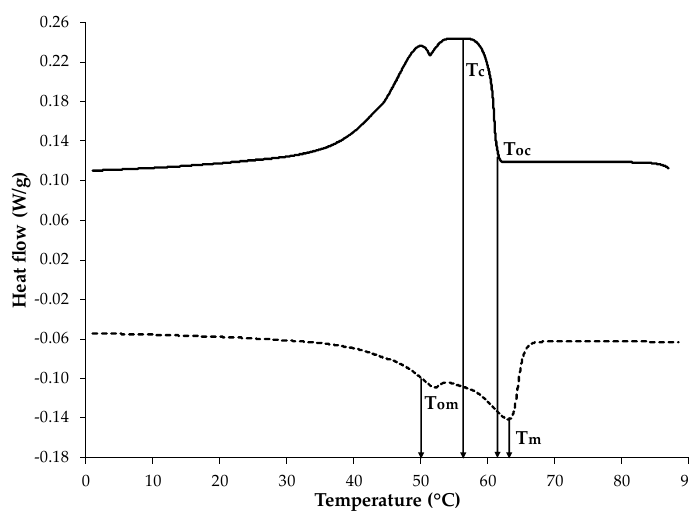
Figure 1. Representative beeswax thermogram: crystallization process (continuous line) and melting process (dotted line), (T oc : crystallization onset temperature; T c : maximum crystallization peak; T om : melting onset temperature; T m : maximum melting peak).